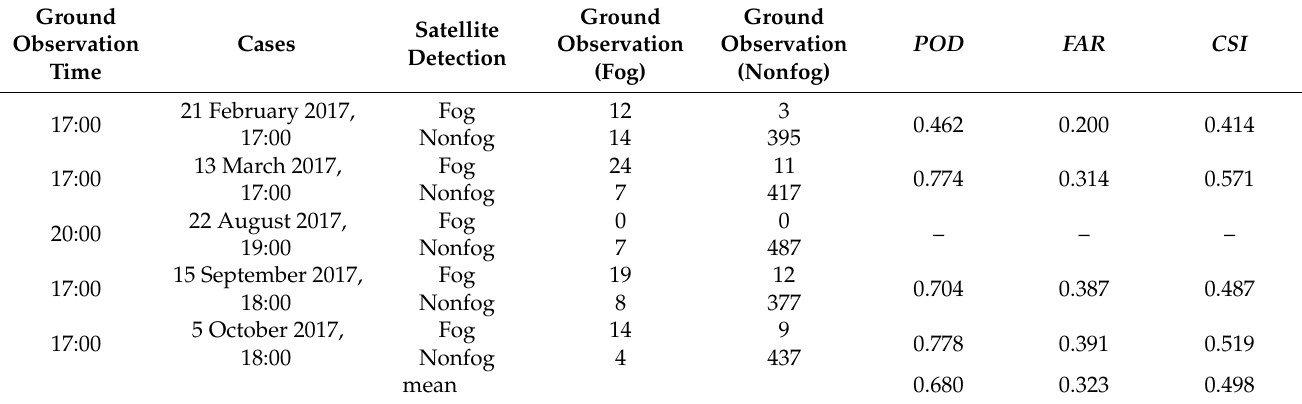
Table 5. Fog detection accuracy at dusk over different seasons.